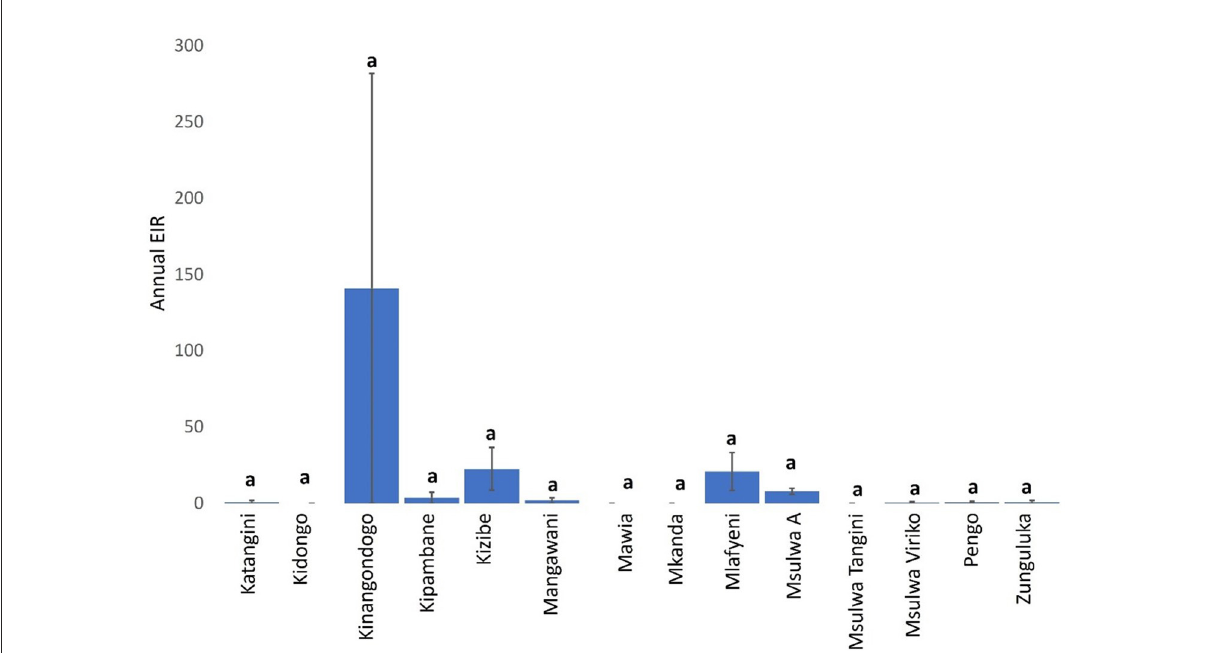
FIGURE6 Annual EIR of tsetse flies according to study-block. Error bars are used to indicate the standard error of the mean (SEM). Same letters on top of vertical bars have been used to indicate absence of significant difference in pairwise comparisons of tsetse fly entomological inoculation rates in study